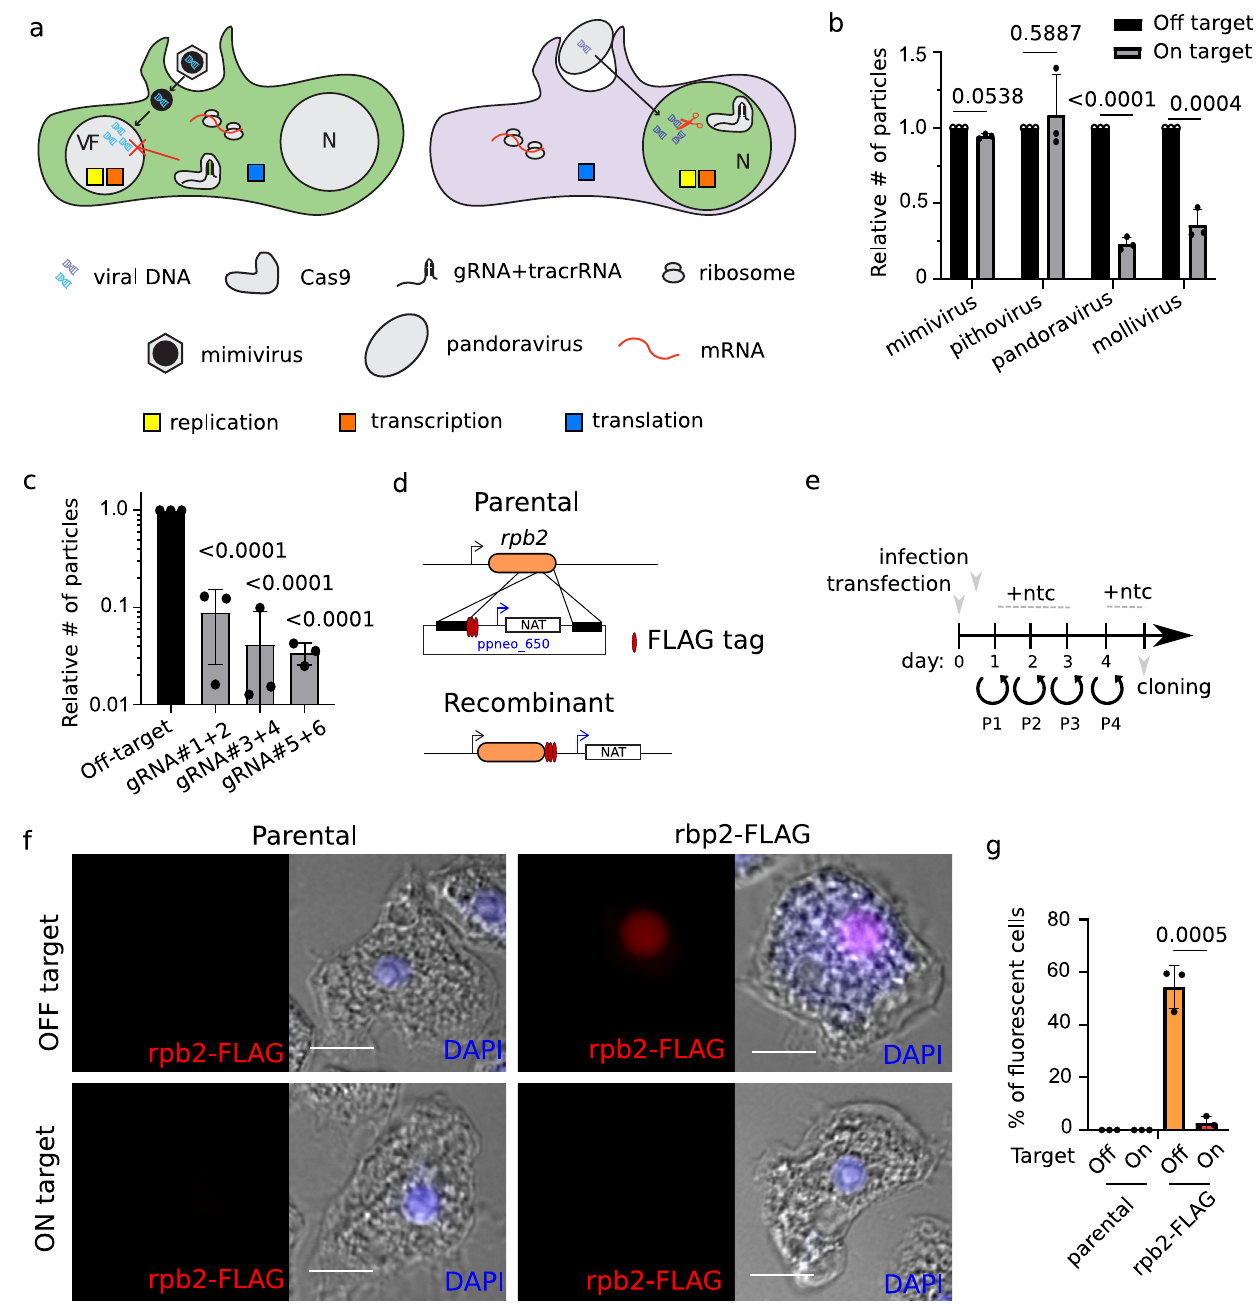
Fig. 3| CRISPR/Cas9allowsmanipulationofnuclearGVs.a Schematicdepiction of genetic manipulation of GVs. A. castellanii expressing a nuclear or cytoplasmic Cas9 are shown in the left and right, respectively. VF: viral factory. N: Nucleus. b Quanti fi cation of the number (#)of virusesproduced 24h post-infection(hpi) of CRISPR/Cas9 expressing amoebas. Values are expressed relative to # of viral par- ticles produced within amoebas expressing off-target gRNAs. A cytoplasmic ver- sion of Cas9 was used to attempt gene disruption of cytoplasmic GV ( Mimivirus reunion 28 and Pithovirussibericum 27 )and anuclearversionofCas9wasused forthe gene disruption of nuclear GVs ( Pandoravirus neocaledonia 3 and Mollivirus kamchatka 26 ). Data correspond to the mean±SD of 3 independent experiments. MOI=1. Guides targeting mimivirus rpb1 were used as off-target gRNAs for pitho- virusinfectionandviceversa.Guidestargetingpandoravirusrpb1wereusedasoff- target gRNAs for the infection of mollivirus and vice versa. The null hypothesis ( α = 0.05) was tested using unpaired two-tailed Student ’ s t tests. c Multiple gRNA combinationswereusedtotargetthe rpb1 geneof Pandoravirusneocaledonia .Data